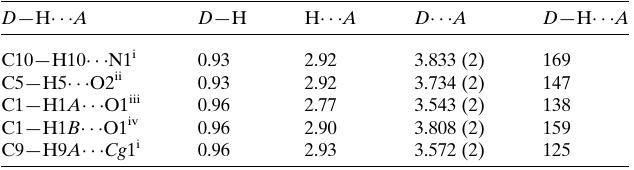
Table 2 Hydrogen-bond geometry (A˚ , (cid:2) ).